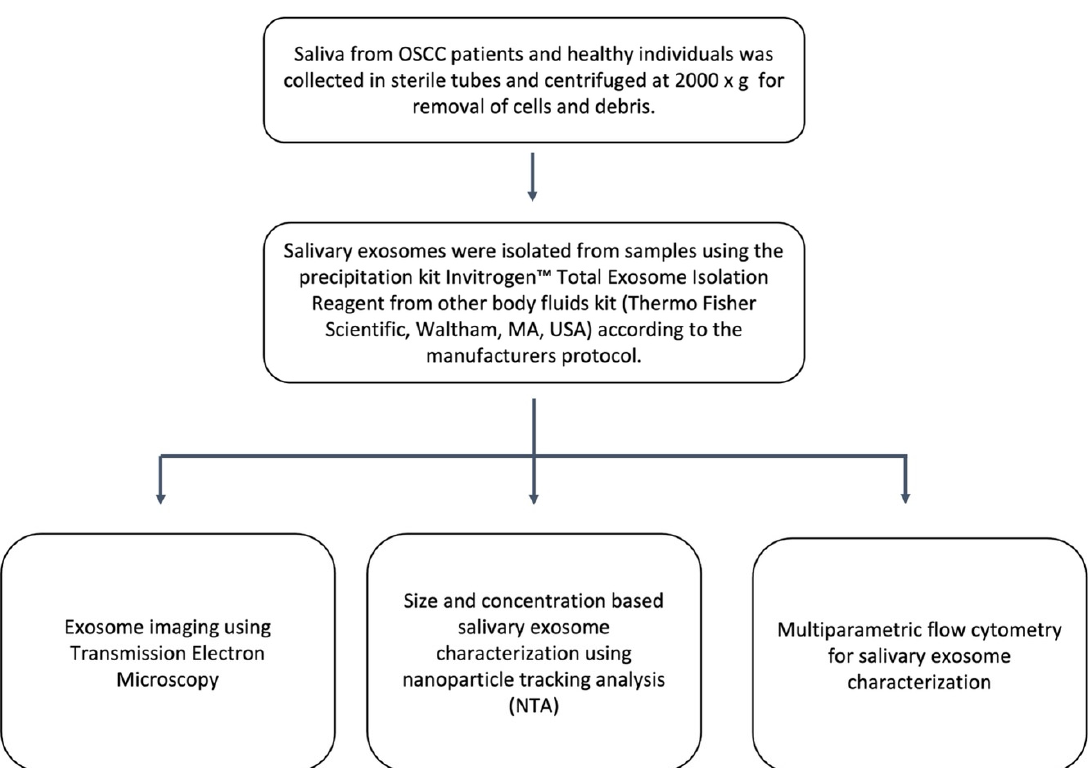
Figure A2. Exosome isolation and characterisation.